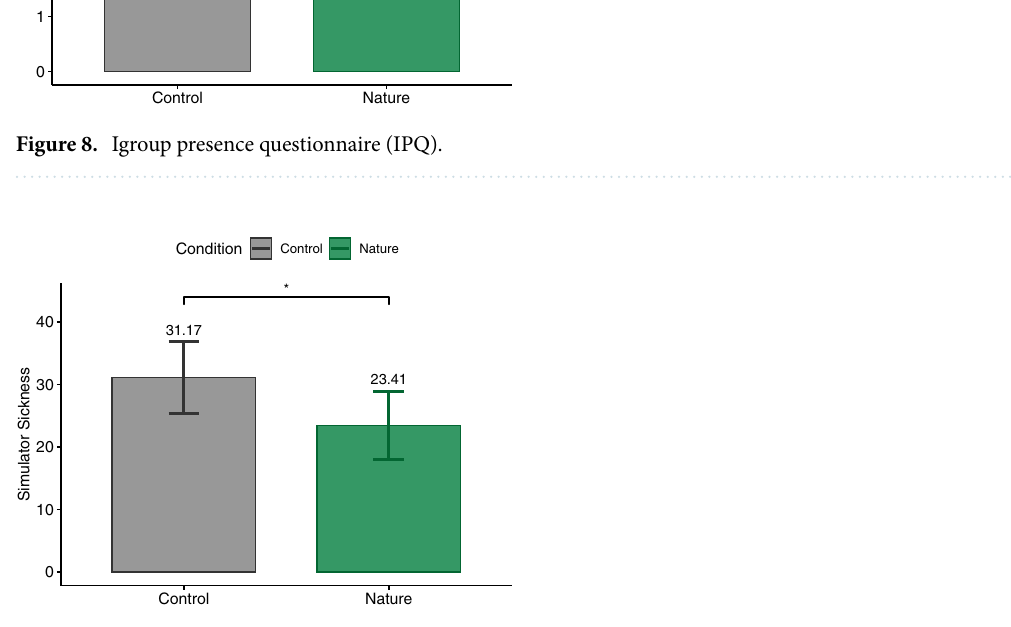
Figure 9. Simulator sickness questionnaire (SSQ) total